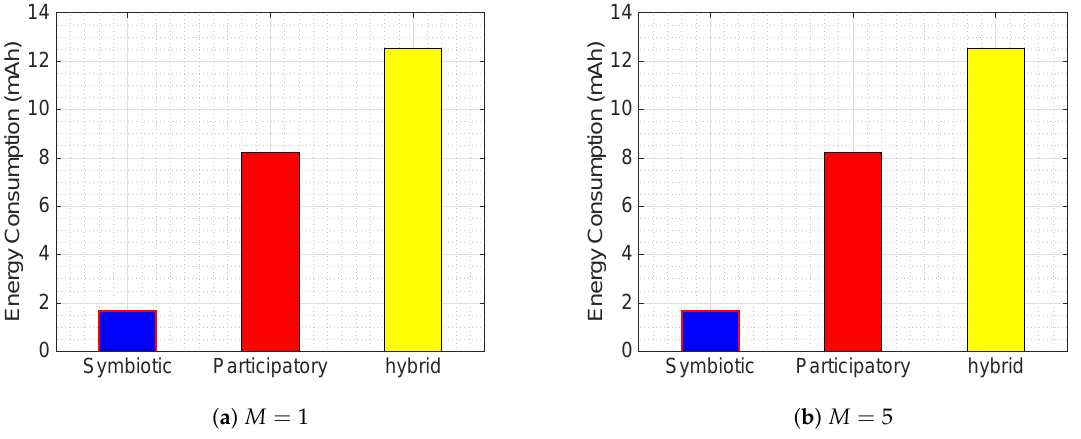
Figure 8. Evaluation of the Ear-Phone [47] city noise map application in terms of the expectation of estimated energy consumption when applying participatory sensing (original work), symbiotic sensing, and hybrid sensing with different minimum required observations: ( a ) M = 1; ( b ) M =